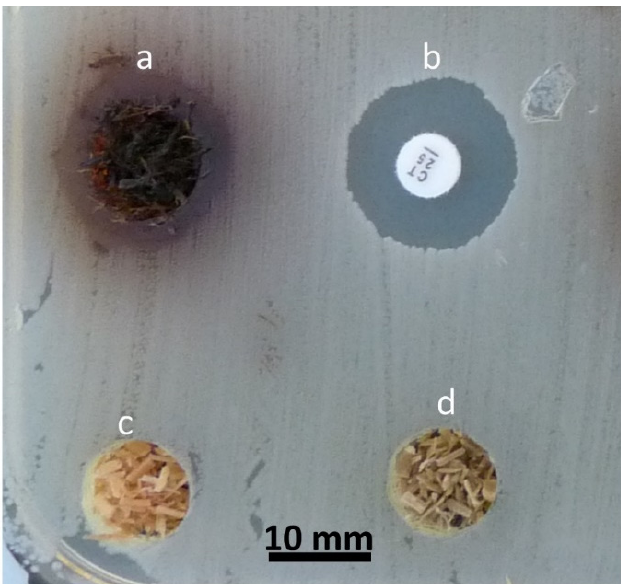
Figure 4. Antibiogram result of the well di ff usion method to test the antimicrobial activity of sawdust (1–2 mm particle size), filled in wells (10 mm diameter) created in Mueller–Hinton agar against Acinetobacter baumannii : ( a ) oak wood showing the zone of inhibition around the well as a positive result; ( b ) positive control antibiotic disc (Colistin (Oxoid, Basingstoke, United Kingdom)–6 mm diameter disc); ( c ) poplar sawdust with no activity, and ( d ) ash sawdust with no antimicrobial activity; ©